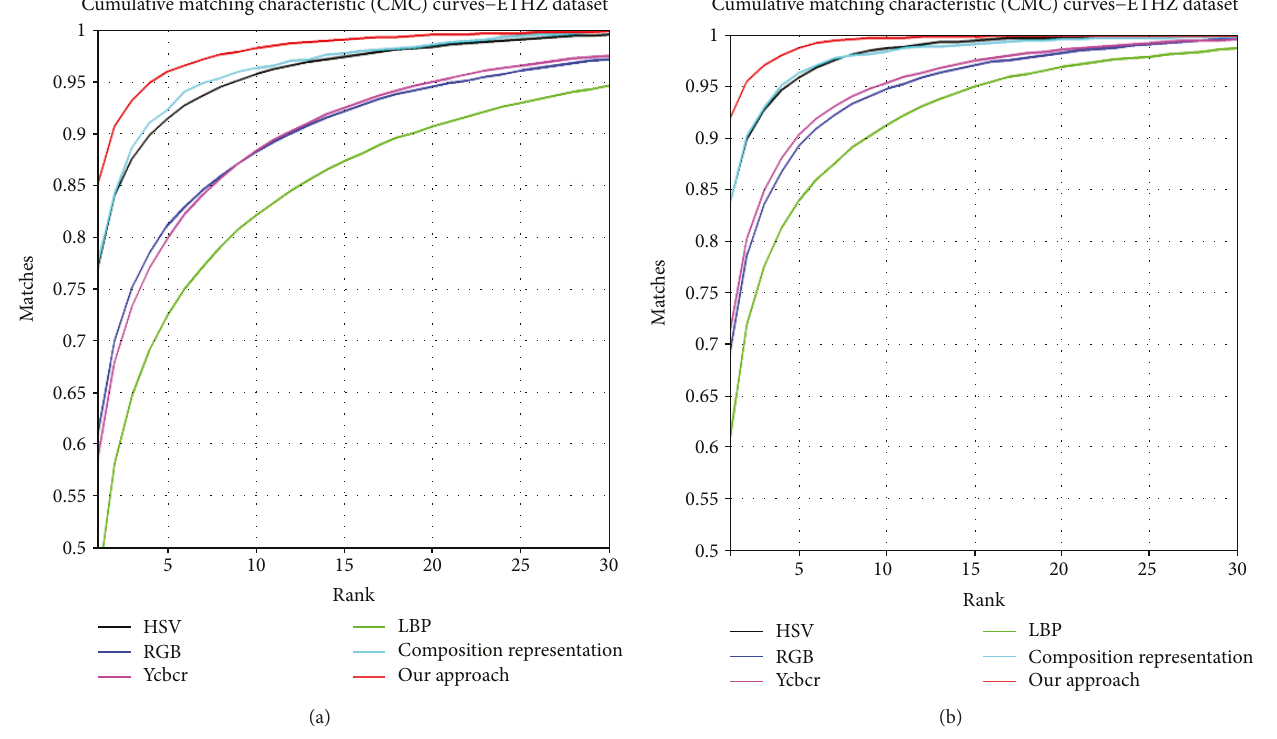
Figure 5: Performance on the ETHZ dataset in terms of CMC curves (top 30 ranking positions). P = 76 samples are selected as the training data in (a). P = 106 samples are selected as the training data in Table 2: Matching rates of di ff erent approaches on the ETHZ dataset.